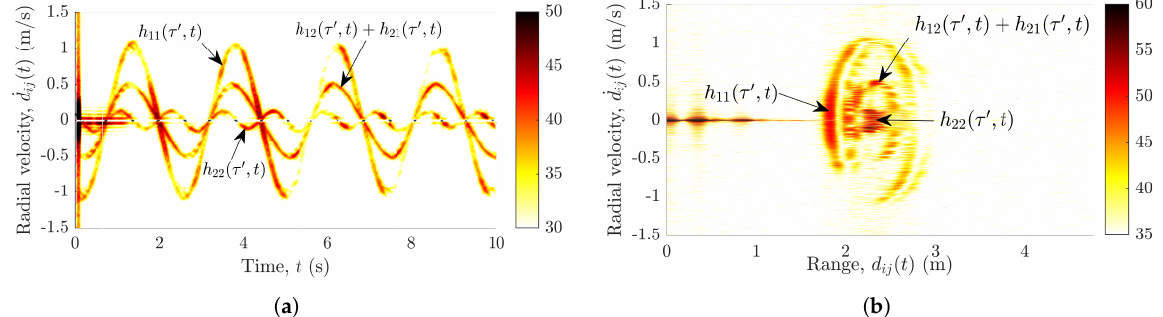
Figure 2. Radial velocity ˙ d ij ( t ) of the pendulum vs. ( a ) time t and ( b ) range d ij ( t ) for the measured subchannel ˜ h 22 ( τ (cid:48) , t )